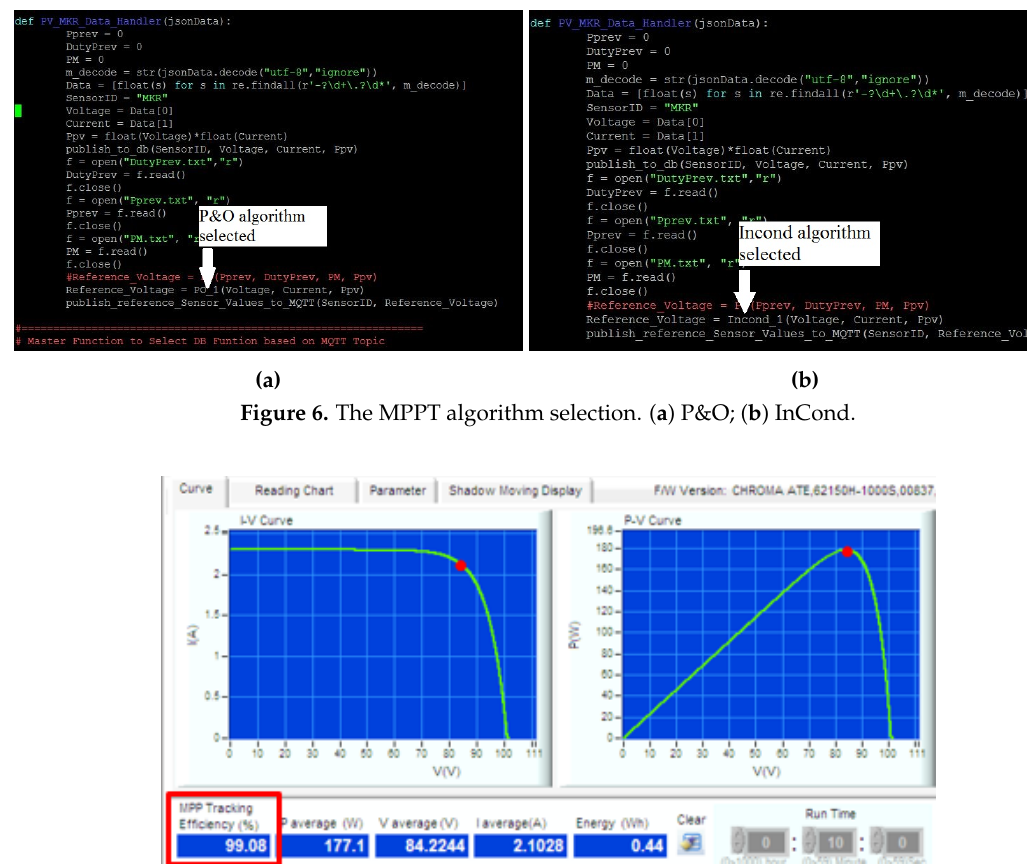
Figure 7. I-V curve and P-V curve of 334 W/m 2 setting.